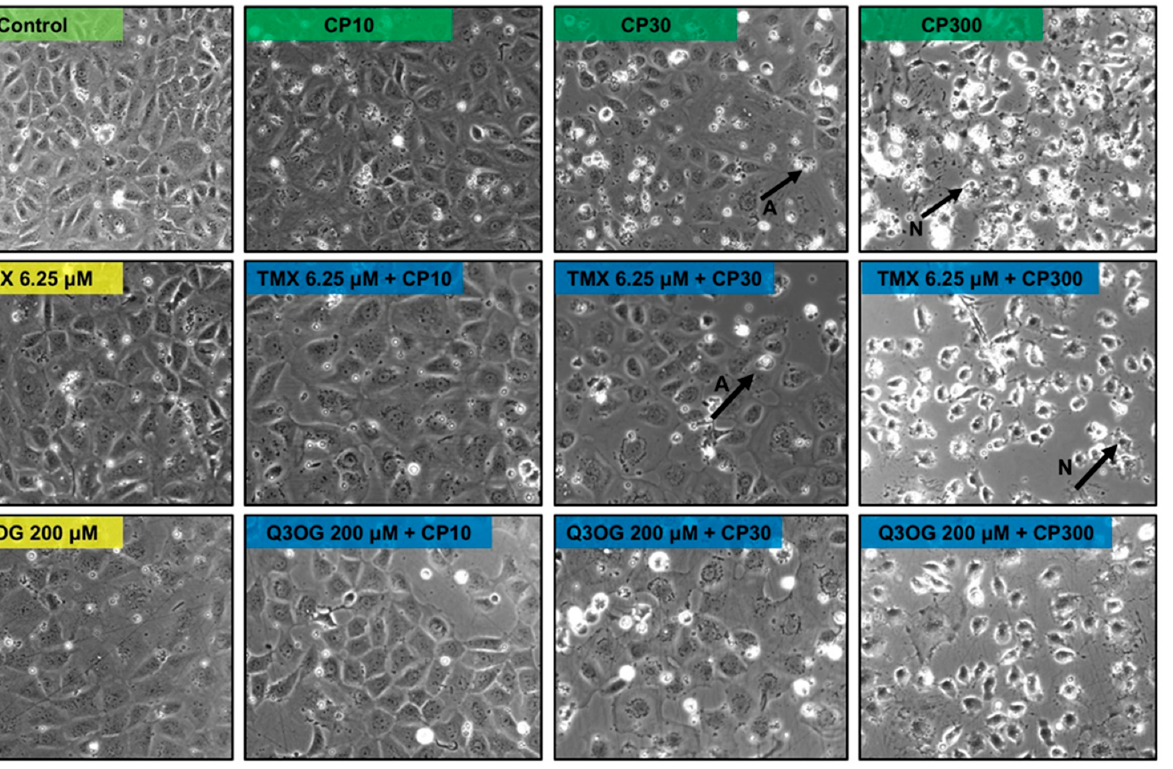
Figure 8. Representative images of NRK-52E cells taken under the light microscope (10× magnifica- tion). First line: cells without treatment (control) and treated with cisplatin 10 (CP10), 30 (CP30) and 300 (CP300) μ M for 18 h. Second line: cells treated with tamarixetin (TMX) at a concentration of 12.5 μ M for 24 h, and cells pre-treated with TMX 12.5 μ M for 6 h and subsequently cotreated 18 h with TMX 12.5 μ M and CP10, CP30 and CP300, respectively. Third line: cells treated with Quercetin 3- O - glucuronide (Q3OG) at a concentration of 25 μ M for 24 h, and cells pre-treated with Q3OG 25 μ M for 6 h and subsequently cotreated for 18 h with Q3OG 25 μ M and CP10, CP30 and CP300, respec- tively. TMX: tamarixetin; Q3OG: quercetin 3- O -glucuronide; CP: cisplatin; A: apoptosis; N: necrosis. Cotreatment with quercetin 25 μ M and cisplatin resulted in a mild increase in cell viability for the three concentrations of cisplatin tested, compared to the single treatment with the drug, although the differences were not significant. On the other hand, cotreat- ment with tamarixetin and cisplatin made no difference compared to treatment without the metabolite. Therefore, tamarixetin does not appear to protect against drug-induced damage in our experiments with NRK-52E cells (Figure 7). As with HK-2 cells, in NRK-52E cells the most interesting results were found with quercetin 3- O -glucuronide. When cells are pretreated and subsequently cotreated with the metabolite in combination with cisplatin at concentrations of 10, 30 and 300 μ M, an increase in cell viability of 20, 10 and 10%, respectively, was observed, in comparison with treatments without metabolite. This result indicates that glucuronide cotreatment at a con- centration of 200 μ M induces cellular protection, thus avoiding or reducing the damage